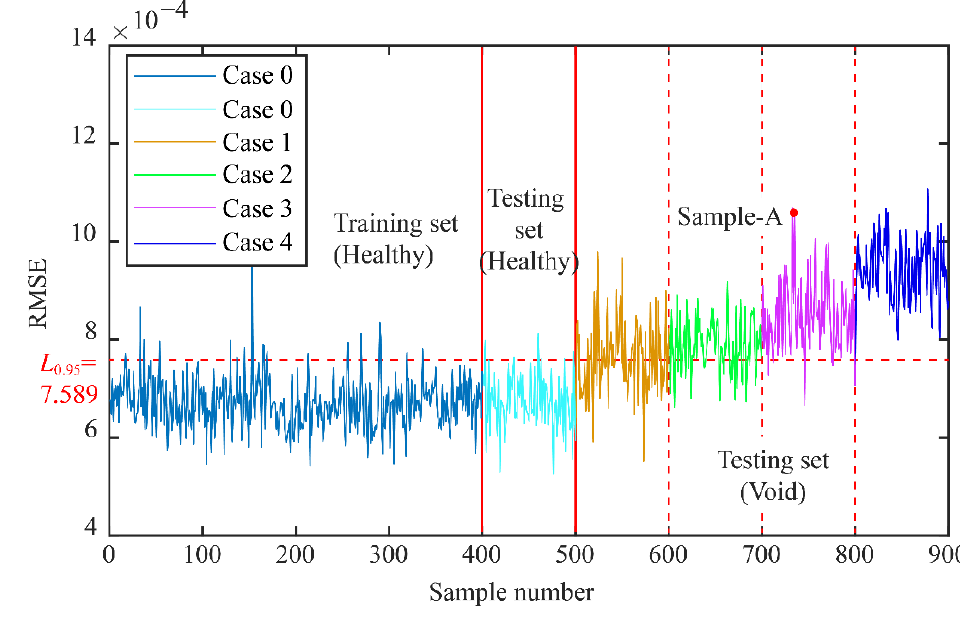
Figure 9. Void identification using CVAE.